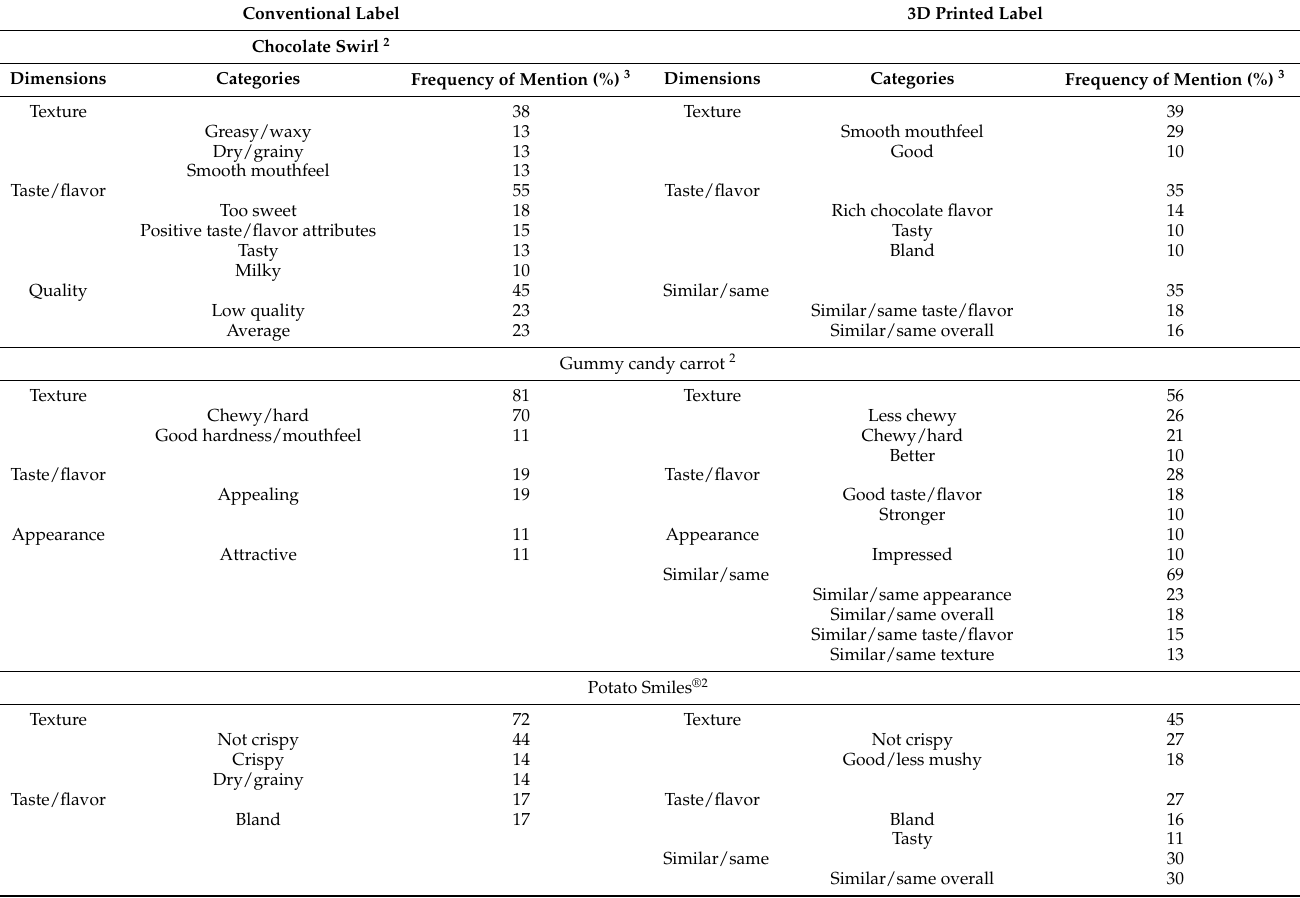
Table 3. Participant sensory perception comments 1 of identical food samples labeled as conventional and 3D